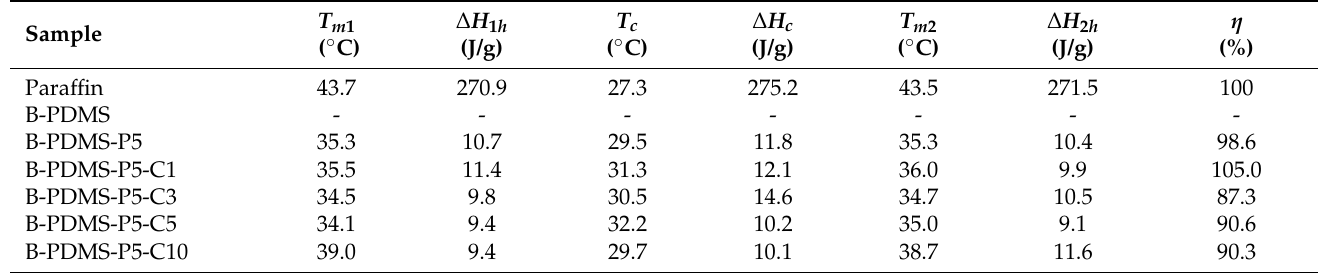
Figure 6. DSC thermograms of some selected compositions (bulk samples): ( a ) first heating scan; ( b ) cooling scan. Table 4. Main results of the DSC tests on the prepared bulk